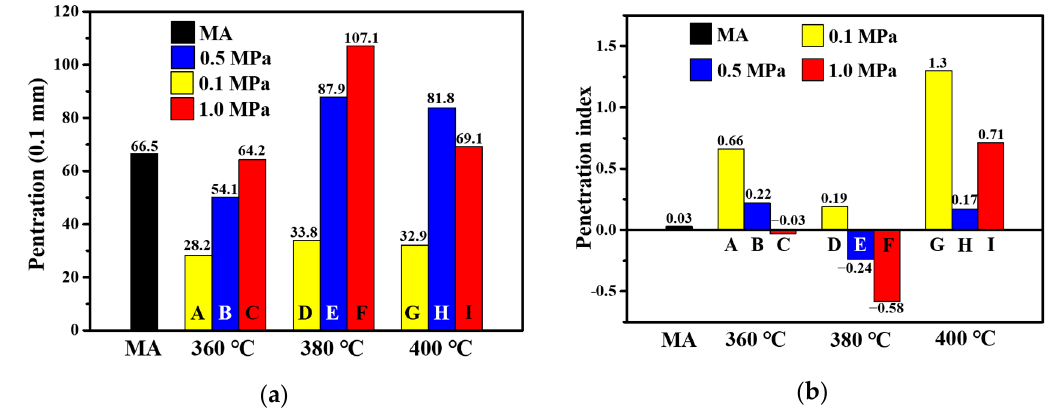
Figure 4. Penetration ( a ) and penetration index ( b ) of MA and PPWA.